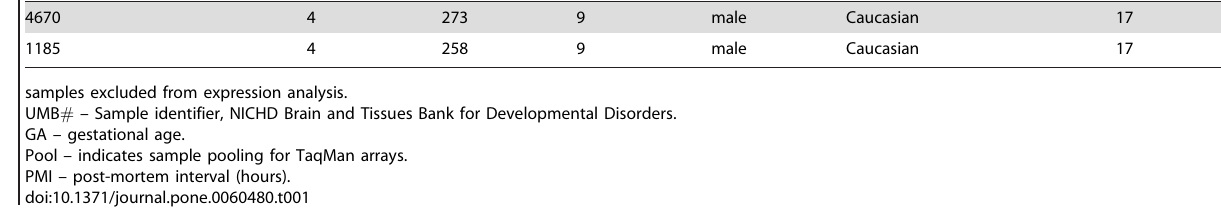
probes for validated human miRNAs from miRBase release 10.0, as well as 373 Invitrogen novel human miRNAs. After filtering, the final data set consisted of 464 genes which could be assessed for differential expression between the time points. 312 had signifi- cantly different expression between at least two of the sample types, broadly defined as fetal, young and adult. Developmental expression patterns for these 312 miRNAs were analyzed using correlation-based hierarchical clustering ( Figure 1 ). Samples from developmentally proximal time points had more similar miRNA expression signatures, suggesting that a global miRNA expression